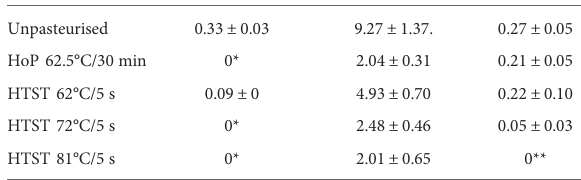
Shown are mean±standard deviation from 6 measurement of each parameter for each